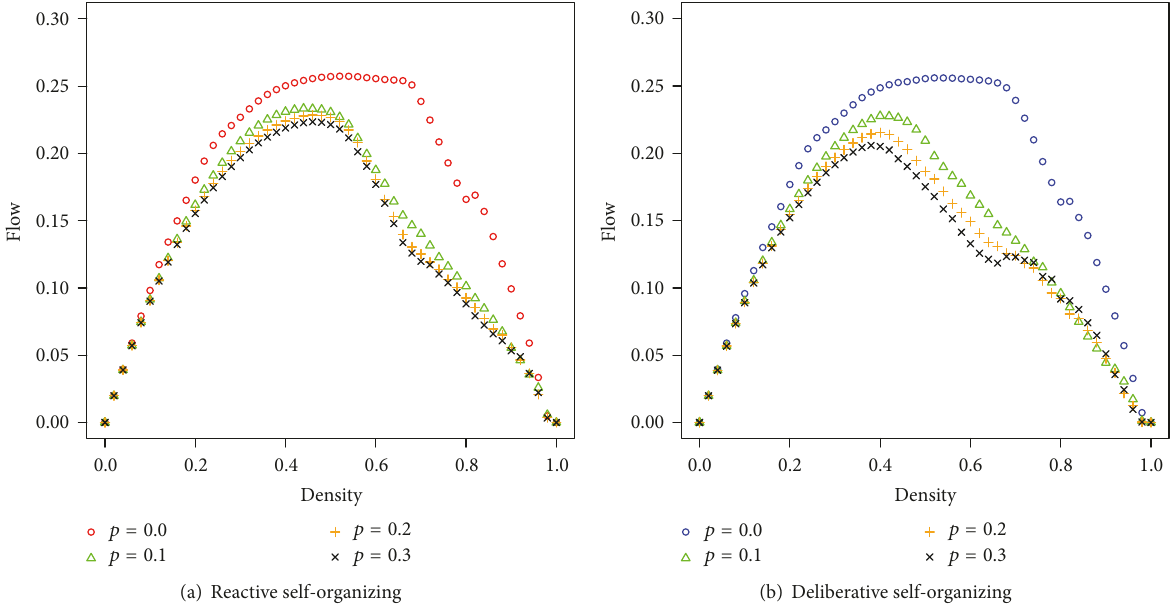
Figure 11: Flow-density and velocity-density diagrams for different probabilities of turn in the reactive and deliberative